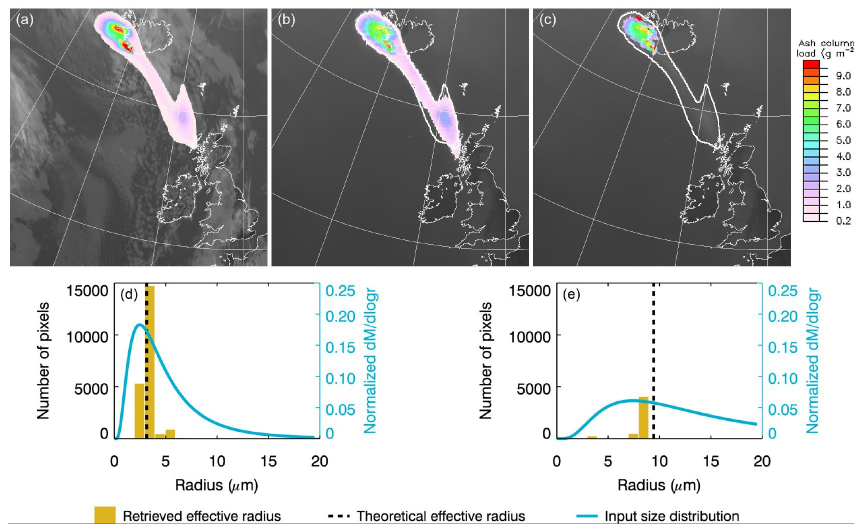
Figure 9. Ash mass loading and effective radius data for 12:00UTC on 14 May 2010. (a) NAME ash column mass loading overlaid on the SEVIRI 10.8µm BT image for the corresponding time. (b) and (c) Retrieved ash column mass loading data from simulated SEVIRI infrared data using a lognormal PSD with geometric standard deviation of 2.0 and a mass median radius of 4 and 12 µm respectively. The light grey line in (b) and (c) shows the extent of the NAME ash coverage (where mass loading > 0.2 gm − 2 ); this is overlaid on a simulated 10.8µm infrared image (simulated without clouds). Slightly cooler temperatures indicate the presence of volcanic ash within the zone of NAME ash coverage, which may be identified by a skilled forecaster. (d) and (e) Histograms of retrieved effective radii from the same simulated SEVIRI data as (b) and (c) respectively. The blue curves in (d) and (e) show the input mass PSD, while the dotted line shows the corresponding theoretical effective